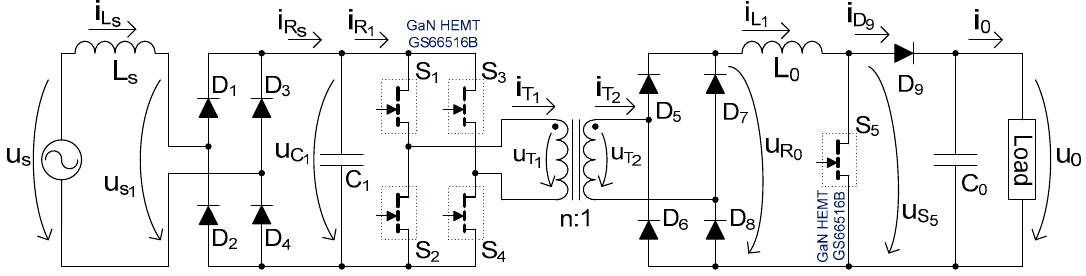
Figure 1. Proposed isolated AC-DC for DC low-voltage residential networks.